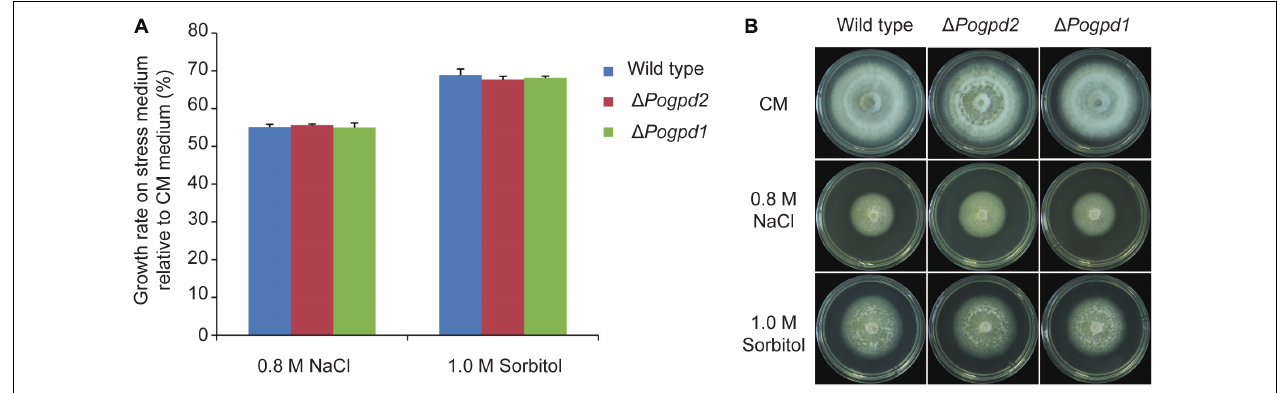
FIGURE 2 | Roles of glycerol-3-phosphate dehydrogenases in response to osmotic stress. (A) Relative growth rate on CM medium containing 0.8 M NaCl or 1.0 M sorbitol by (cid:49) Pogpd1 and (cid:49) Pogpd2 . Error bars represent SD. No significant differences were found between the wild type and the mutants as estimated by Tukey’s HSD test ( P < 0.05). (B) Mycelial colonies of wild type, (cid:49) Pogpd1 , and (cid:49) Pogpd2 grown on osmotic stress media for 8 days.